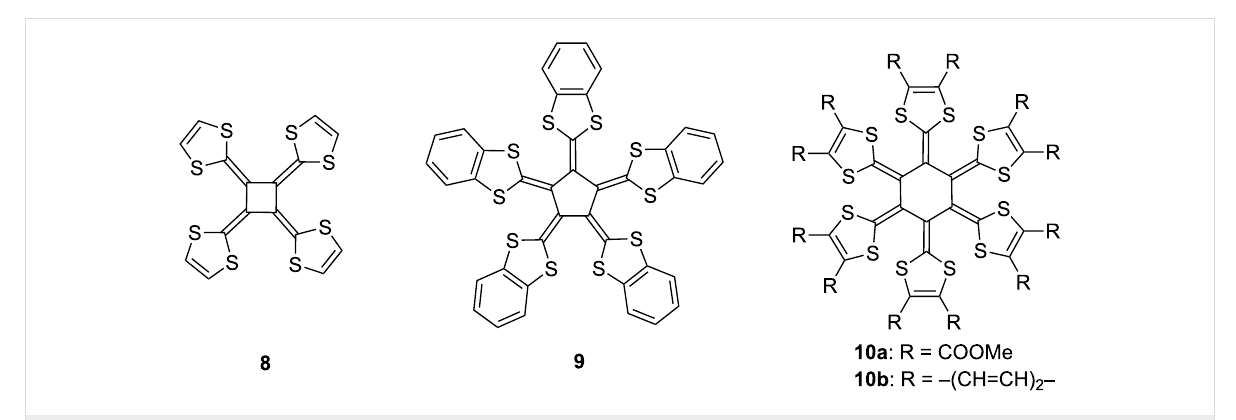
Figure 4: Radially expanded TTF derivatives 8 , 9 , and 10a , b